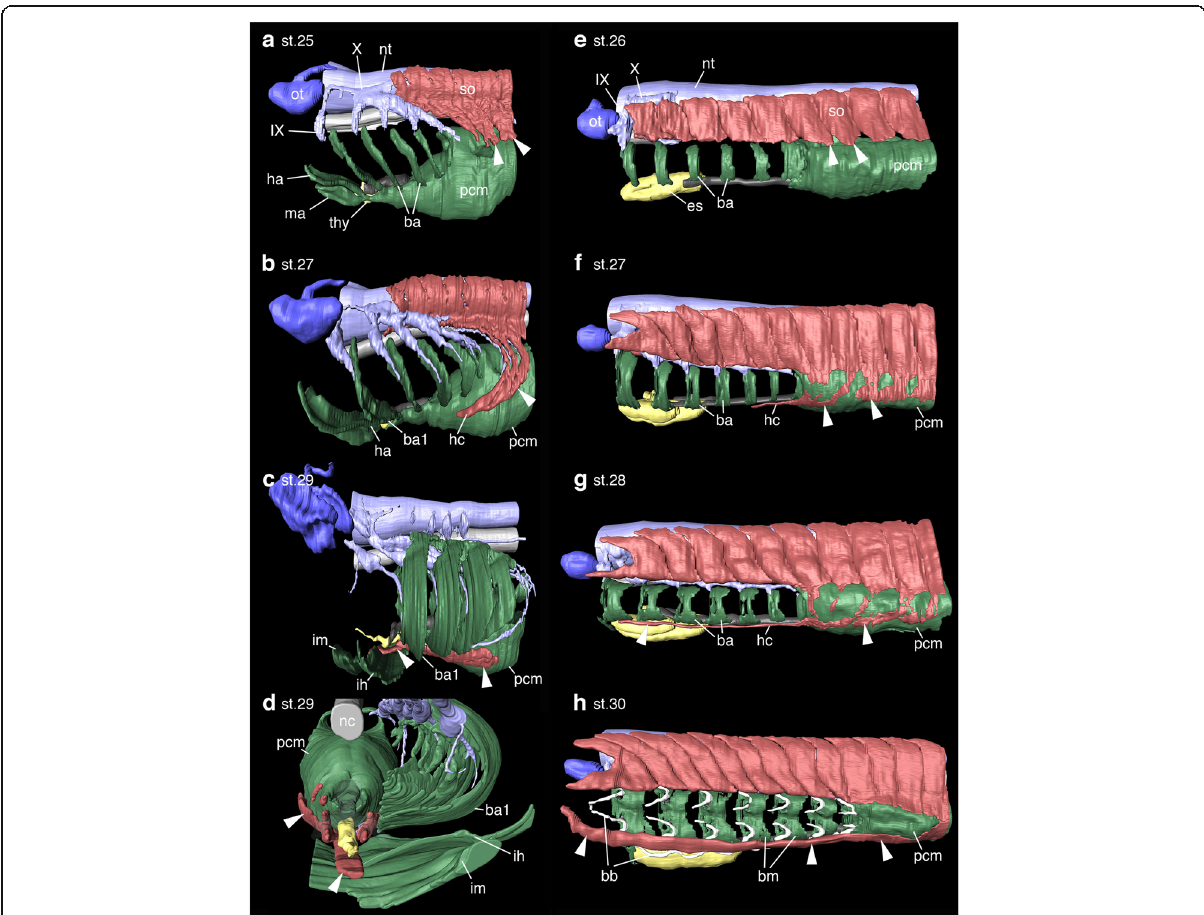
Fig. 4 Developmental sequence of HBMs. a - h , 3D reconstruction images of shark ( a - d ) and lamprey ( e - g ) embryos from lateral view. ( d ) Anterior view of ( c ) with translucent ventral aorta. Somites developed ventrally sending HBM precursors (arrowheads) lateral to the pericardial mesoderm in both species ( a , b , e and f ). HBM precursors developed inward being surrounded laterally and ventrally by mandibular and hyoid muscles in sharks ( c , d ), whereas the precursors extended outside the branchial muscles and skeletons in lampreys ( g , h ). Somites detached from HBM precursors ( c ) and right pharyngeal muscles ( d ) are not shown. ba, branchial arch mesoderm; ba1, first branchial arch mesoderm; bb, branchial basket; bm, branchial muscles; es, endostyle; ha, hyoid arch mesoderm; hc, hypoglossal cord; ih interhyoideus; im, intermandibularis; ma, mandibular arch mesoderm; nc, notochord; nt, neural tube; ot, otic vesicle; pcm, pericardial mesoderm; so, somites; thy thyroid gland; IX, glossopharyngeal nerve; X, vagus